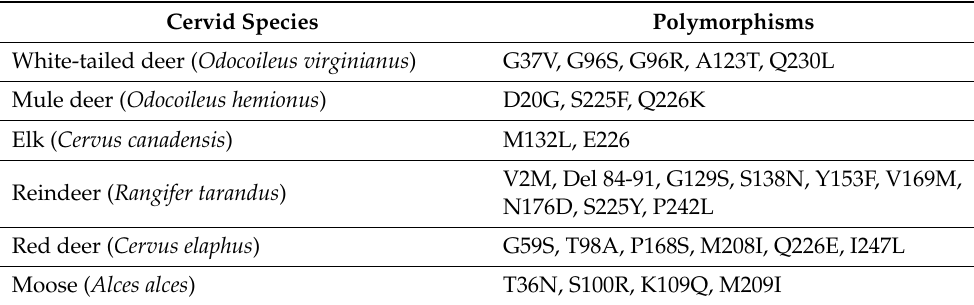
Table 1. Natural Prnp polymorphisms found in various species of cervids. Cervid Species